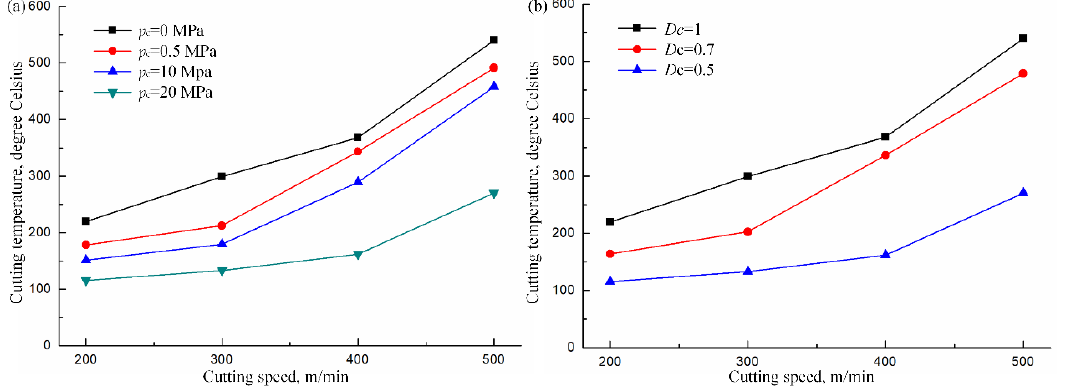
Figure 10. Cutting temperature versus cutting speed of HUVC Ti alloys, ( a ) effects of cooling pressure, duty cycle is 0.5, ( b ) effects of duty cycle, cooling pressure is 20 MPa. Feed per revolution and cutting depth are 0.005 mm/r and 0.05 mm, respectively. p c , cooling pressure, D c, duty cycle.